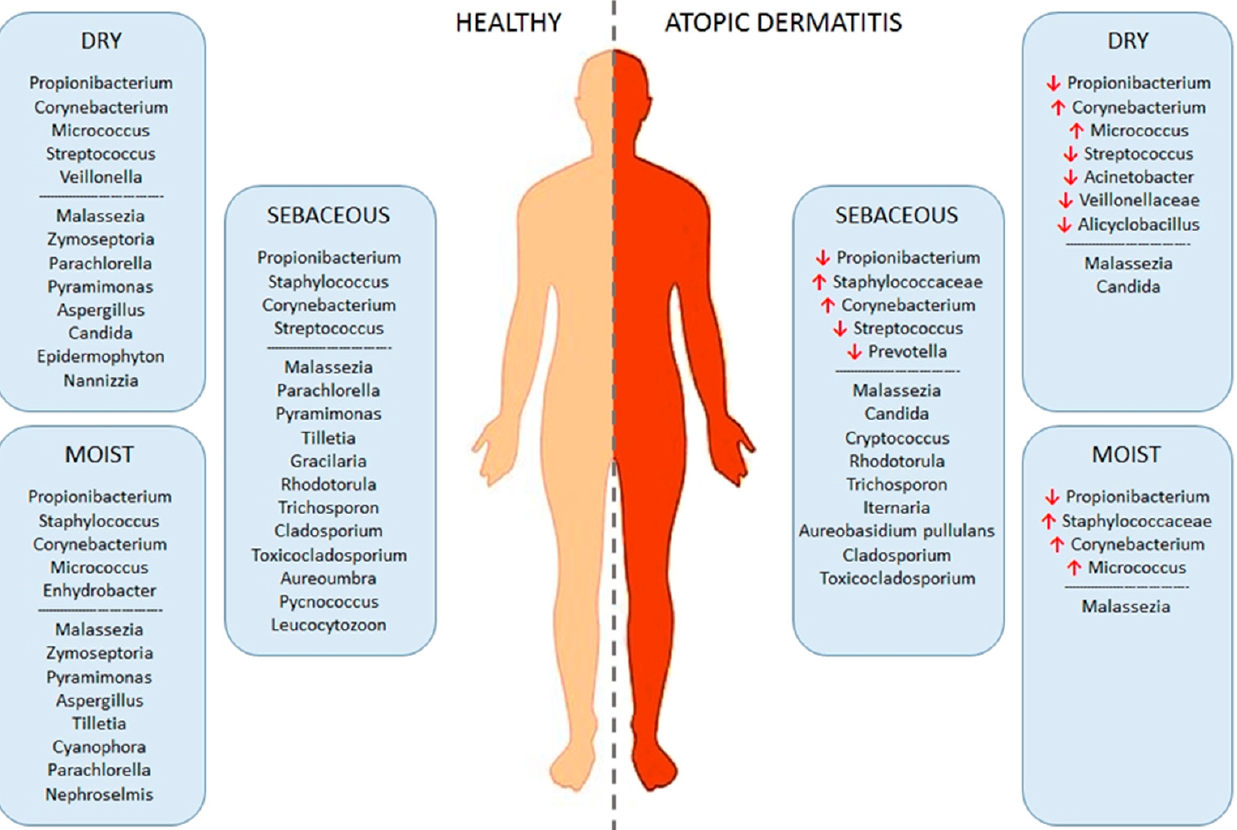
Figure 3. Comparison of microbiota composition between healthy skin and skin affected by AD.